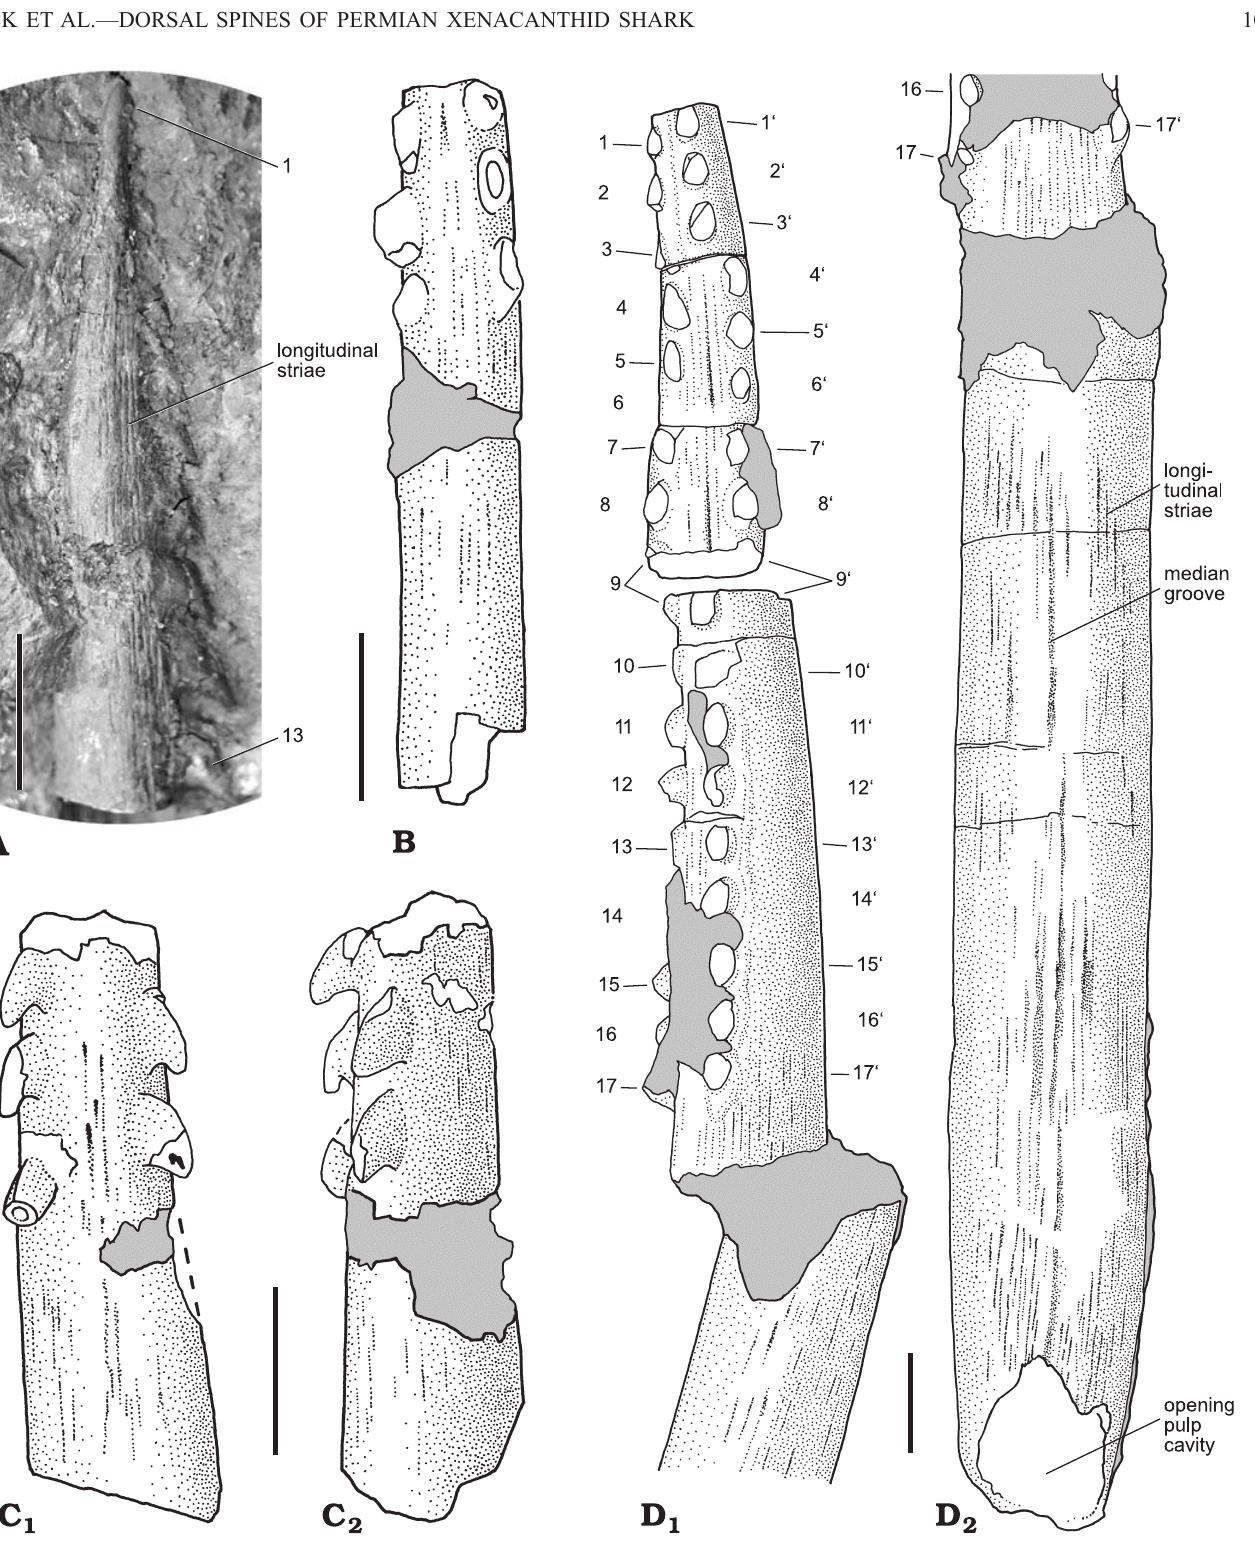
Fig. 3. External morphology of dorsal spines of Orthacanthus platypternus (Cope, 1884), Lower Permian, Craddock Bone Bed, Texas, USA. A . HMNS-T1, juvenile, lateral view. B . SMU 68799, juvenile, posterior view. C . SMU 68800, juvenile, posterior (C 1 ) and postero-lateral (C 2 ) views. D . SMU 68801, adult, denticulated, postero-lateral view (D 1 ) and non-denticulated, posterior view (D 2 ) regions. Numbers 1 to 17 point to the positions of the denticles along the posterior sides of the spines. Numbers 1’ to 17’ correspond to the right row of denticles. Grey areas in B–D 2 represent sedimentary matrix. Scale bars 5